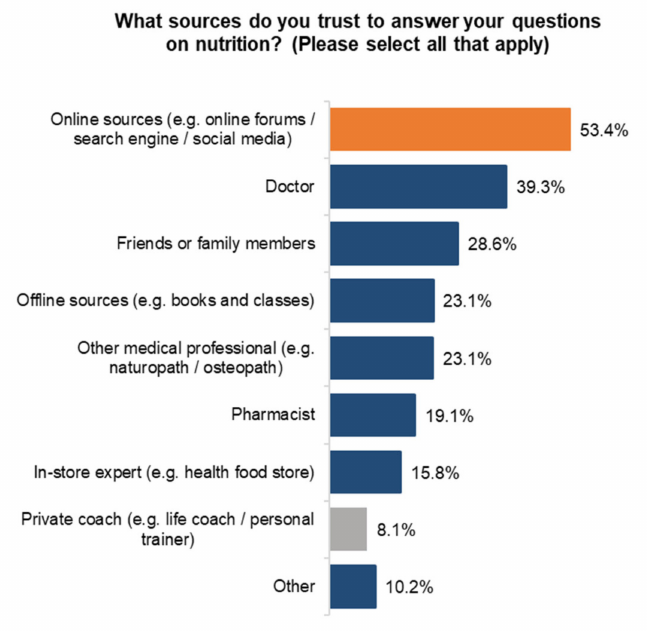
Figure 5. Nutrition sources of information used.